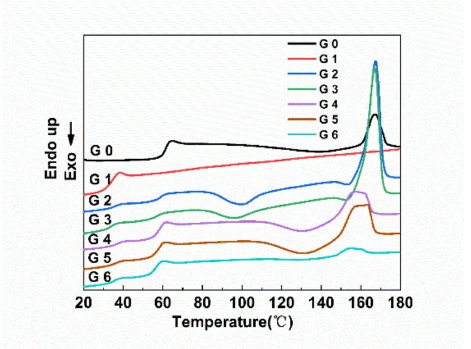
Figure 6. DSC curves of PLA, PPC, PLA/PPC and the PLA/PPC/PLA-g-GMA blends. (G0: PLA; G1: PPC; G2: PLA/PPC; G3: PLA/PPC/PLA-g-GMA; G4: PLA/PPC/PLA-g-GMA/St; G5: PLA/PPC/PLA- g GMA/AMS; G6: PLA/PPC/PLA-g-GMA/EP).